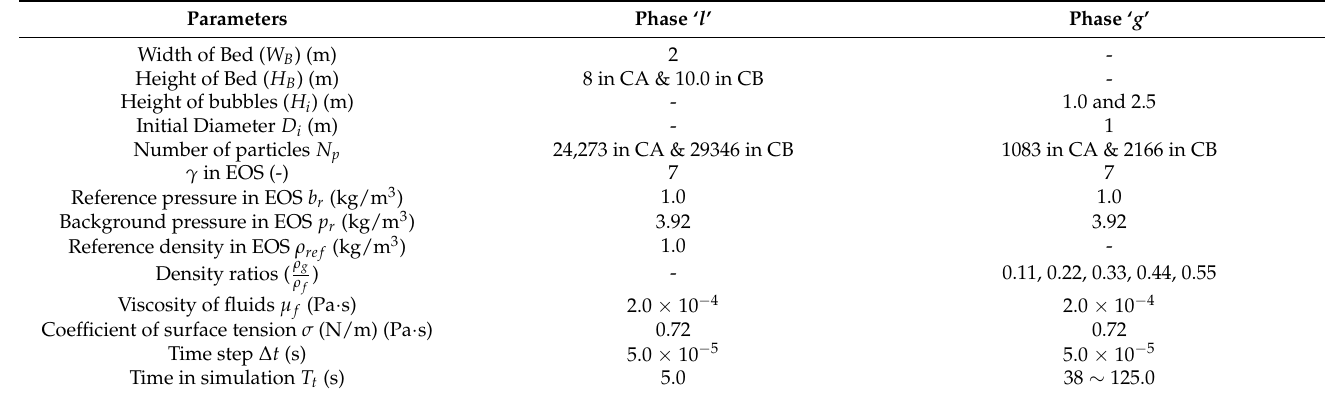
Table 3. Parameters used in Case A (CA) and Case B (CB) for rising bubbles in fluids